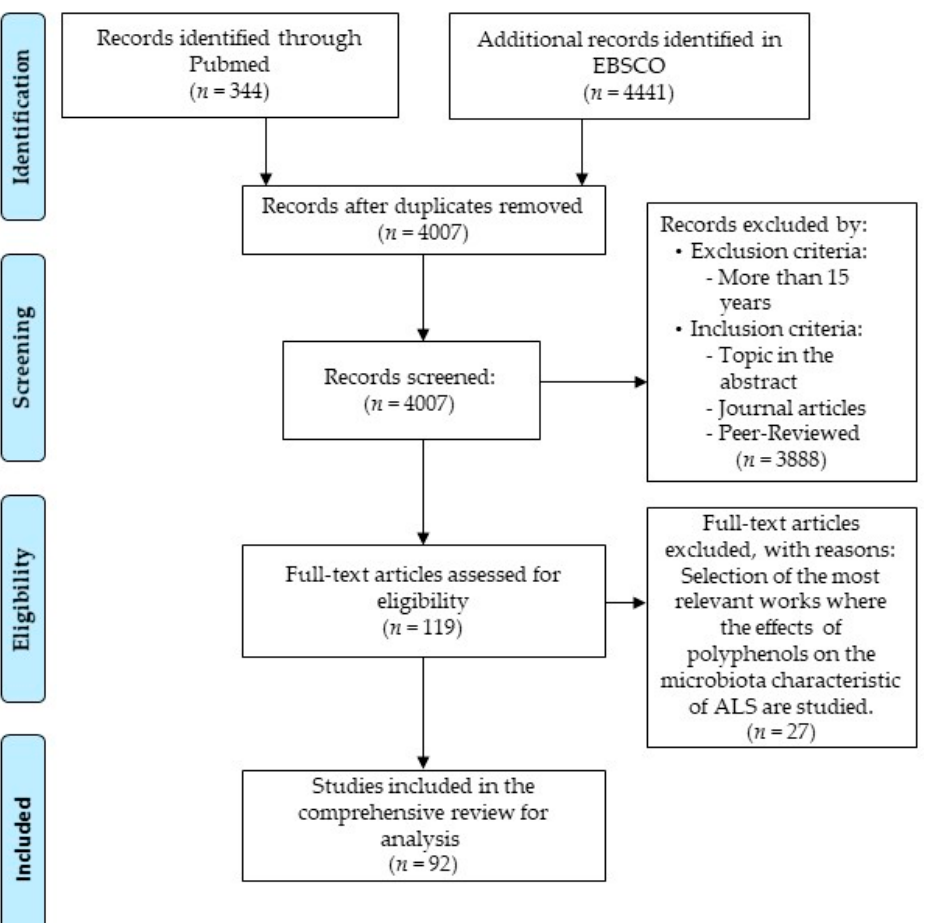
Figure 1. Consort Flow, based on the Preferred Reporting Items for Systematic Reviews and Meta-Analyses (PRISMA) template [34].